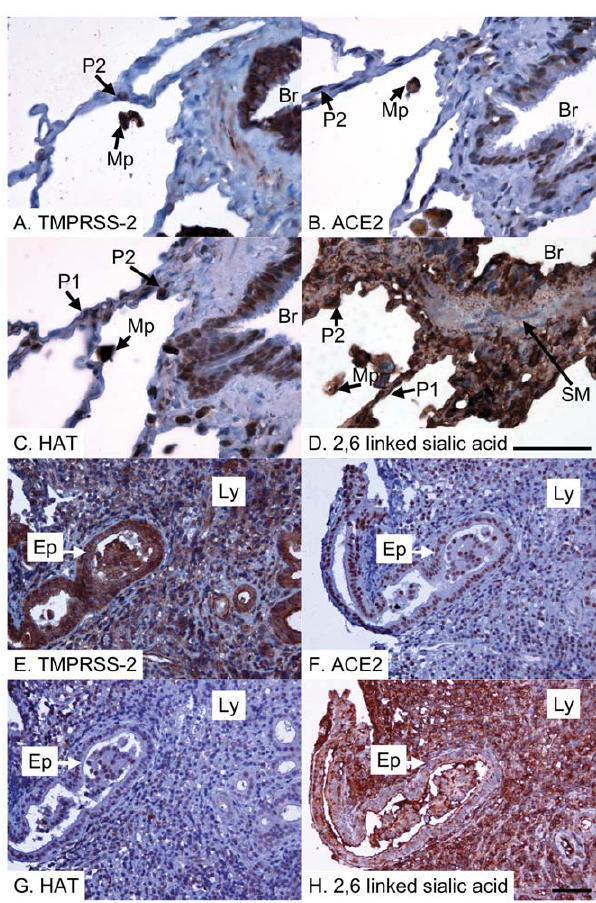
Figure 2. Pulmonary and respiratory sinus expression of SARS- CoV and influenza virus activating proteases and receptors. Lung (A–D) and sinus (E–H) tissue immunostained for TMPRSS2 (A&E), ACE2 (B&F) and HAT (C&G), or stained for 2,6-linked sialic acid (D&H; detected with elderberry ( Sambucus nigra ) lectin). All positive reactions are detected with the peroxidase technique (brown) and the tissue is counterstained with haematoxylin (blue). (A) There is strong positive anti-TMPRSS2 immunostaining of bronchial epithelium (lining the bronchus, marked Br), type 2 pneumocytes (P2) and alveolar macrophages (Mp). (B) There is moderately strong positive anti-ACE2 immunostaining of bronchial epithelium (lining the bronchus, marked Br), type 2 pneumocytes (P2) and alveolar macrophages (Mp). (C) There is moderately positive anti-HAT immunostaining of bronchial epitheli- um (lining the bronchus, marked Br) and alveolar macrophages (Mp), with weakly positive immunostaining of some type 1 (P1) and type 2 pneumocytes (P2). (D) All structures are strongly stained for 2,6-sialic acid except for smooth muscle (SM). (E) There is strong positive anti- TMPRSS2 immunostaining of sinus epithelium (Ep) and lymphoid cells (Ly). (F) There is strong positive anti-ACE2 immunostaining of sinus epithelium (Ep) and lymphoid cells (Ly). (G) There is moderately strong anti-HAT immunostaining of sinus epithelium (Ep) and occasional weakly positive immunostaining of lymphoid cells (Ly). (H) All structures are strongly stained for 2,6-sialic acid. Scale bar=50 microns (shown in panels D and H and also pertaining to 3 preceding panels in each case).